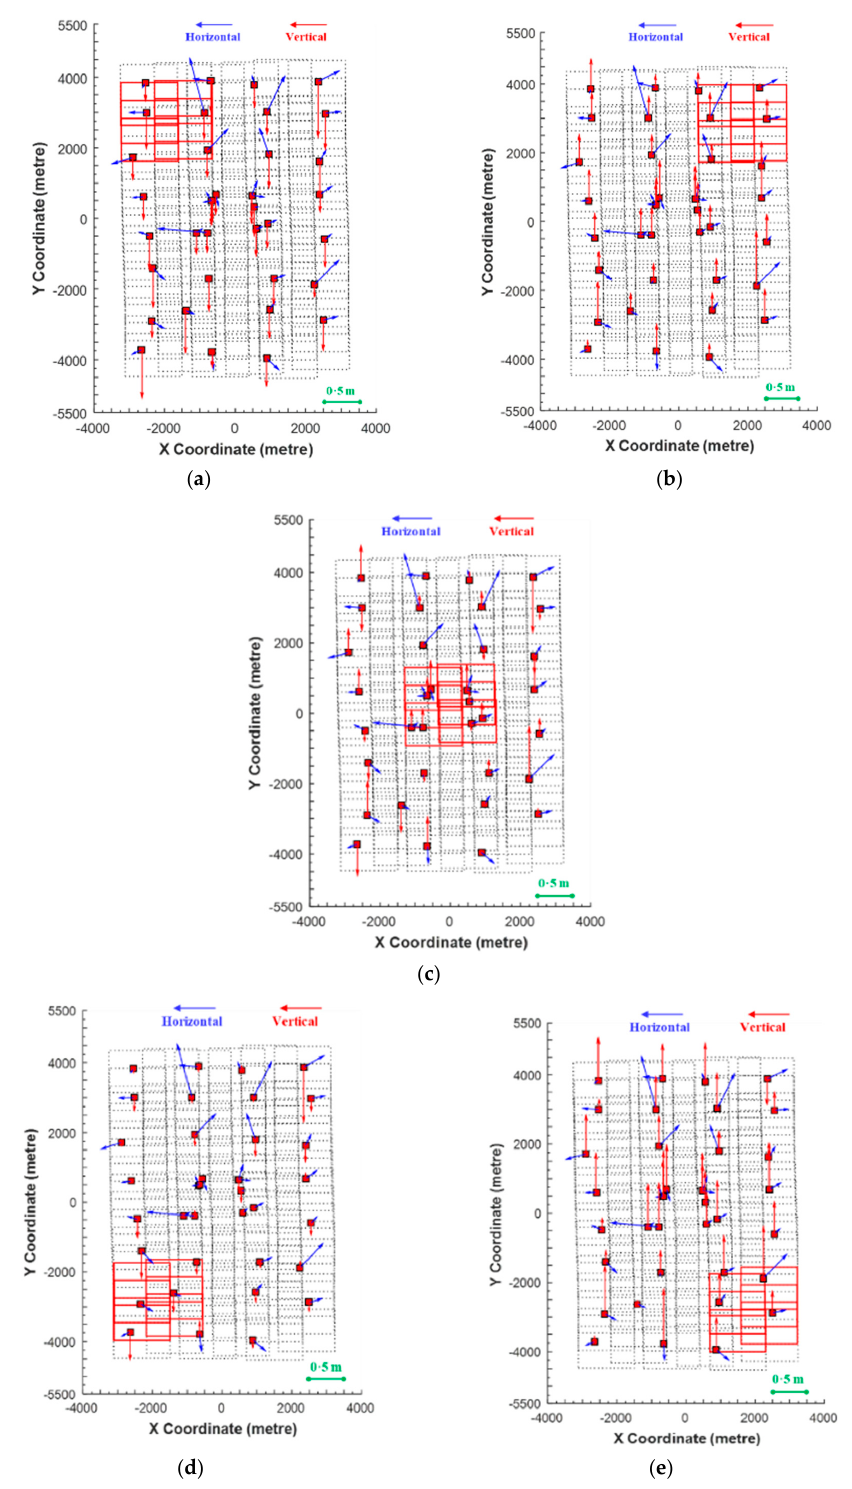
Figure 3. Horizontal and vertical discrepancy vectors in ISO experiments: ( a ) ISO II; ( b ) ISO III; ( c ) ISO I; ( d ) ISO IV; ( e ) ISO